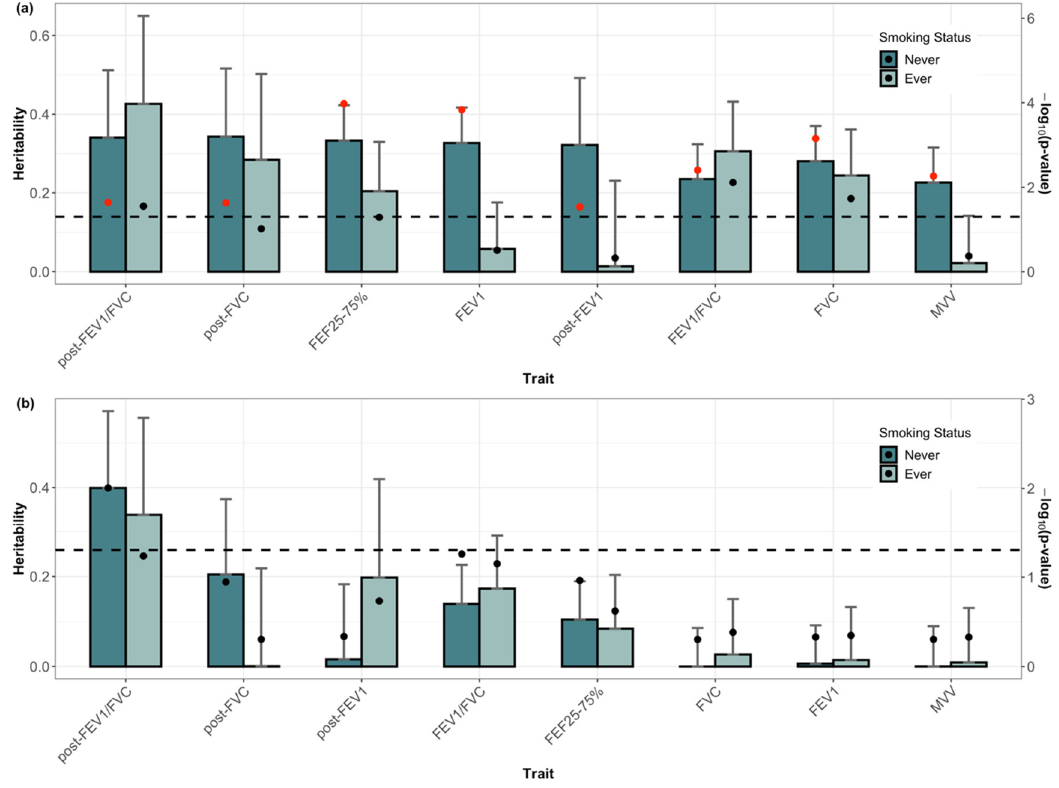
Figure 3. Single nucleotide polymorphism (SNP) heritability of eight lung function traits in never- and ever-smoker groups. SNP heritability of subject-specific means ( a ) and the annual change rates ( b ). Error bars correspond to standard error. The black dot on the bars represent p -values. The black dashed line indicates the 0.05 significance level. Red dots indicate significant findings at a false-discovery rate of 0.05. FVC, forced vital capacity; FEV 1 , forced expiratory volume in 1 s; FEV 1 /FVC, forced expiratory volume in 1 s to forced vital capacity ratio; FEF 25–75%, the average forced expiratory flow during the mid (25–75%) portion of the FVC; MVV, maximal voluntary ventilation; post-FVC, post-bronchodilator test for FVC; post-FEV 1 , post-bronchodilator test for FEV 1 ; post- FEV 1 /FVC, post-bronchodilator test for FEV 1 /FVC ratio.